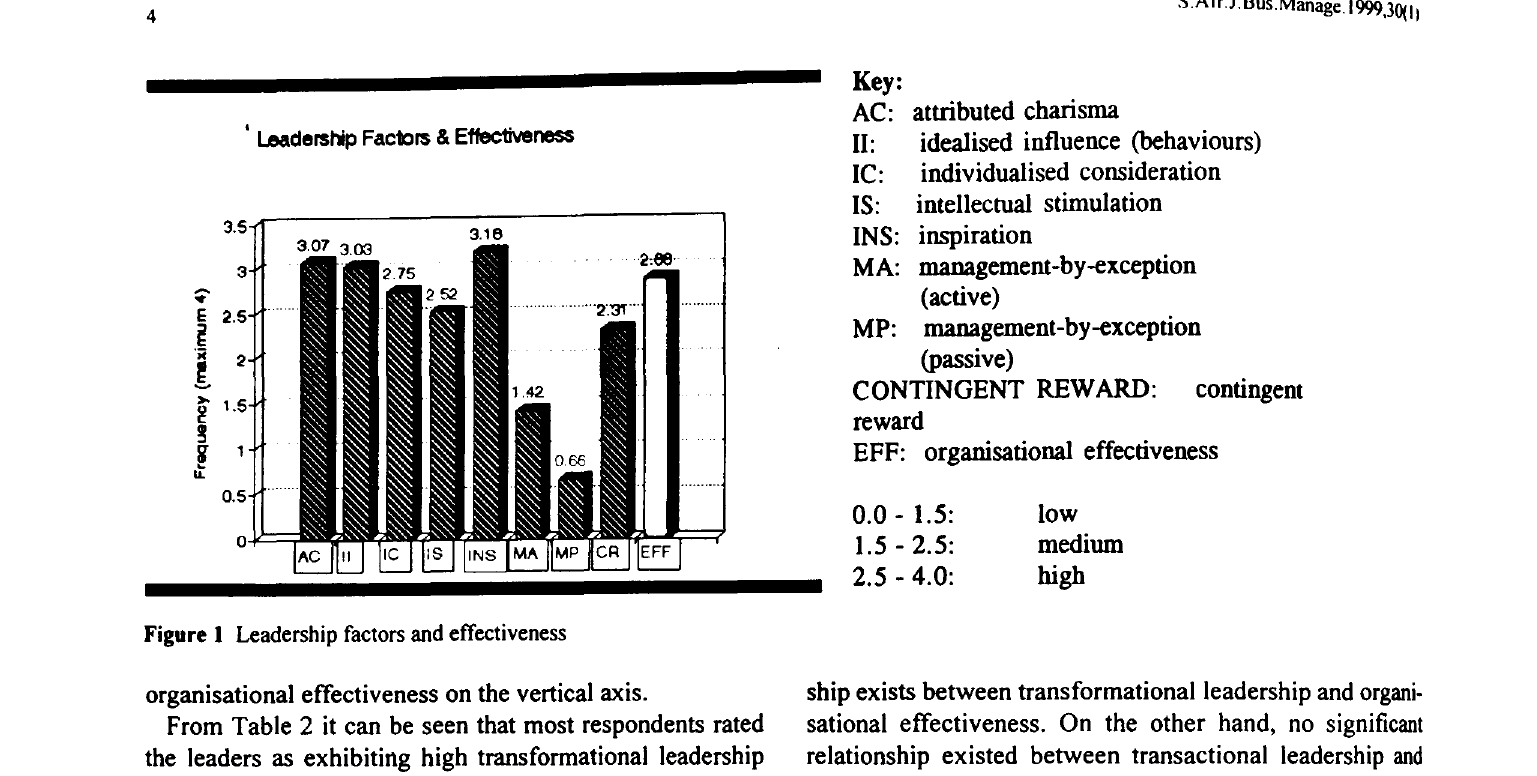
Figure I Leadership factors and effectiveness organisational effectiveness on the vertical axis.